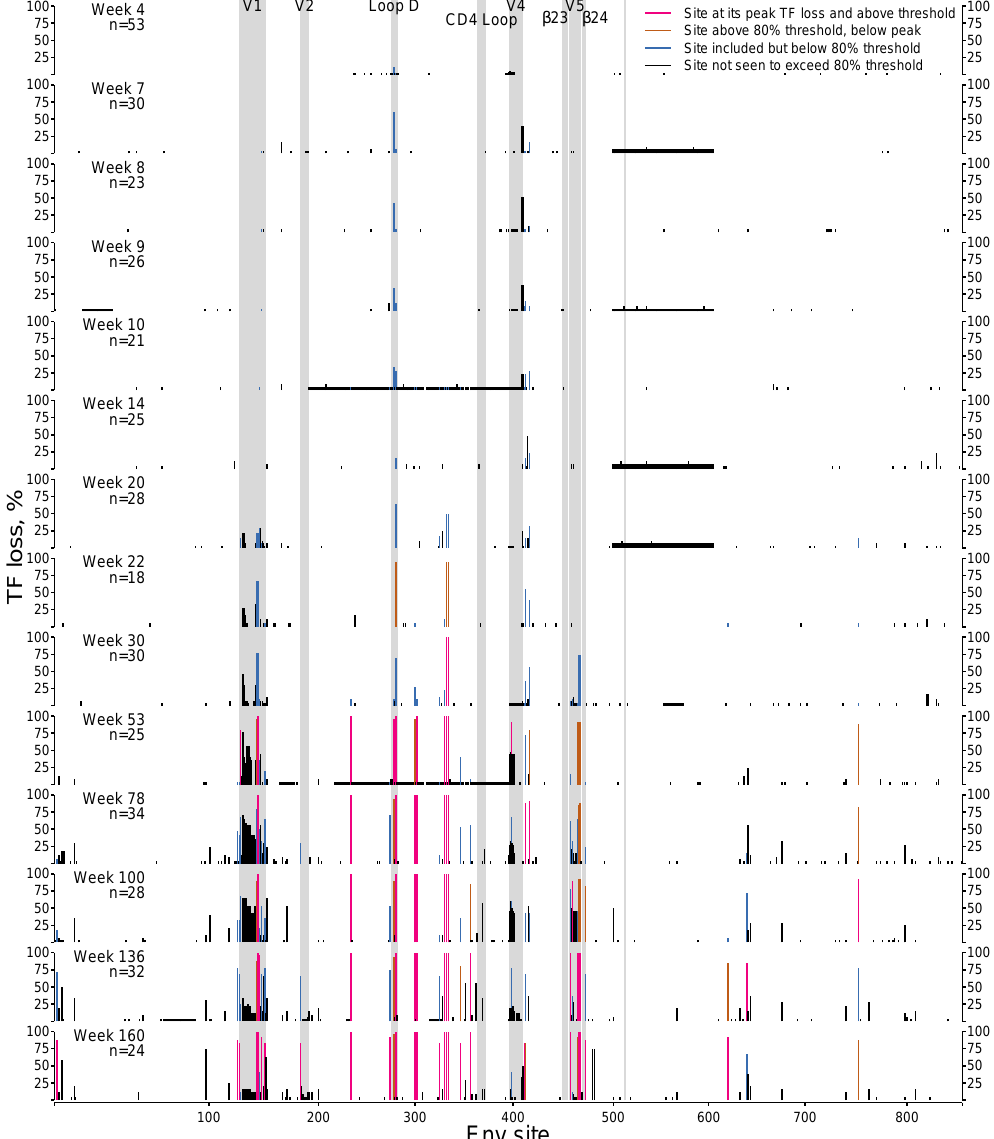
Figure 1. Loss of ancestral transmitted-founder (TF) amino acids in Envs from CH505. For 953 aligned Env sites spanning the full-length protein, TF loss is proportion of non-TF mutations per time-point sampled from the study participant CH505. TF loss is computed for each of 14 time-points sampled longitudinally, weeks 4 through 160, with the number of Envs sequenced ( n ) per time-point as shown. Bar colors vary over time to indicate 35 sites with at least 80% TF loss in any time-point, whether at peak TF loss (pink), below peak but above the 80% cutoff (brown), or below 80% (blue). Variable sites that were not selected for further consideration, because they never exceeded 80% TF loss in ant time-point during the study period, are also depicted (black bars). Grey boxes identify variable loops, which contain hypervariable regions that evolve by insertion and deletion, and other gp120 landmarks. A thin grey line marks the boundary between gp120 and gp41. The time of the sample is shown as weeks post infection. Env site numbers indicate HXB2 positions in the CH505 protein alignment, beginning with the signal peptide start codon in column one and ending with the stop codon at position